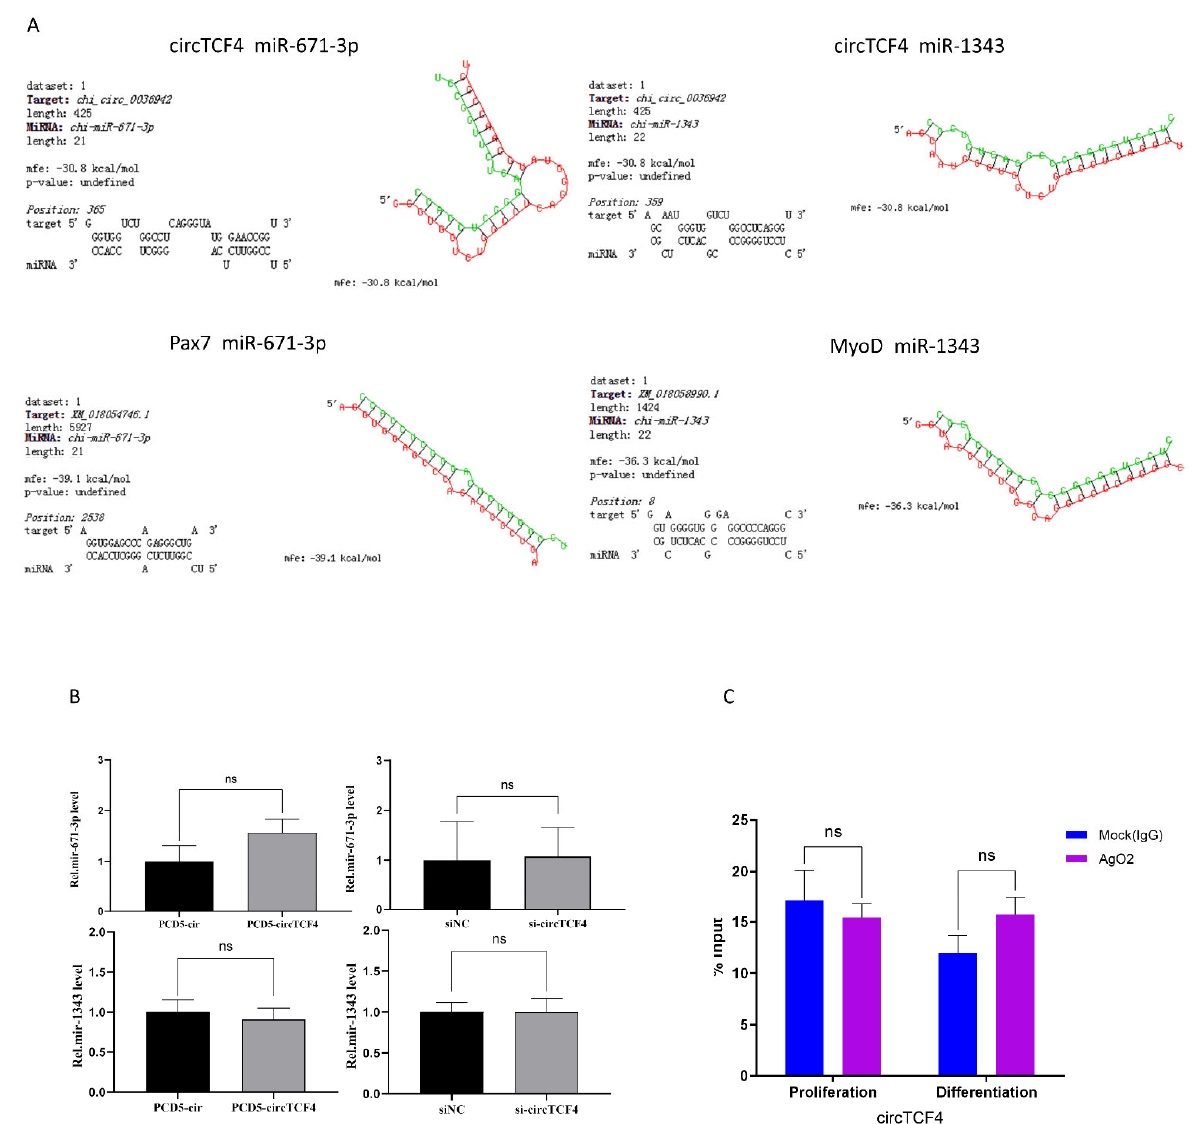
Figure 6. CircTCF4 regulates the proliferation and differentiation of MuSCs independence of miRNAs. ( A ) Predicted binding sites between circTCF4 and mir-671-3p and mir-1343 and downstream target genes. ( B ) Effects of circTCF4 on miR-671-3p and miR-1343 expression. ( C ) circTCF4 enriched in AgO2-RIP. Data are means ± standard error of the mean of at least three biological replicates, ns means insignificant.